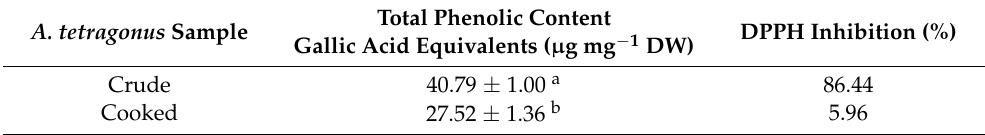
Table 1. Total phenolic content and antioxidant activity of cooked and crude samples of A. tetragonus. The values represent the mean ( n = 3) ± standard deviation. Equal letters indicate no statistically significant differences ( p ≤